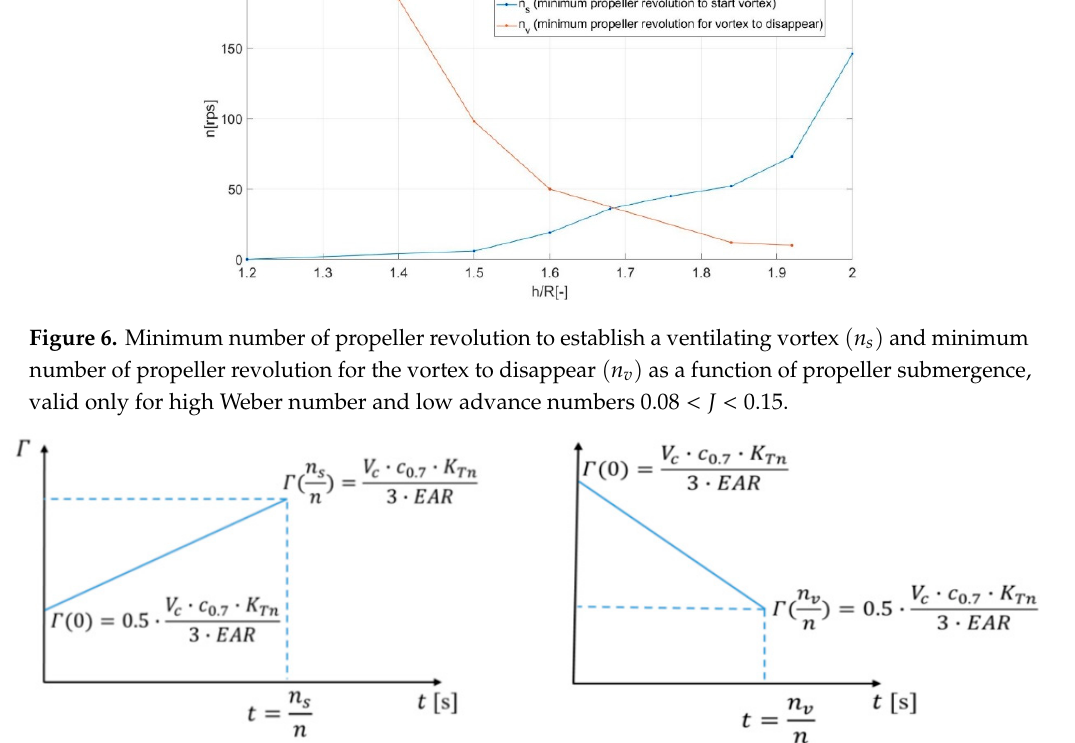
Table 2. Different experimental condition used for comparison between the simulation model and experimental results. Case Number